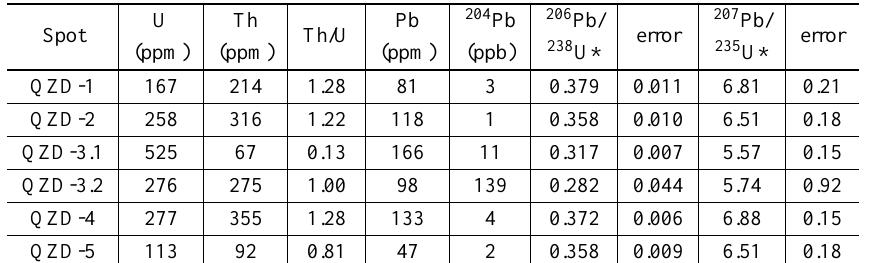
SHRIMP U-Pb data of sample CAWT02 (PC-18E – M-II facies) of the Glória quartz- monzodiorite. The ratios were corrected to common lead ( 204 Pb). See text for details.